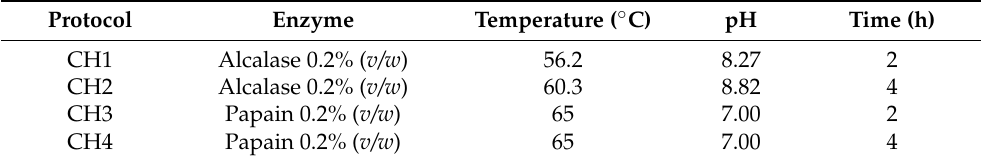
Table 2. Experimental conditions for hydrolysis of skin remains after thermal extraction of